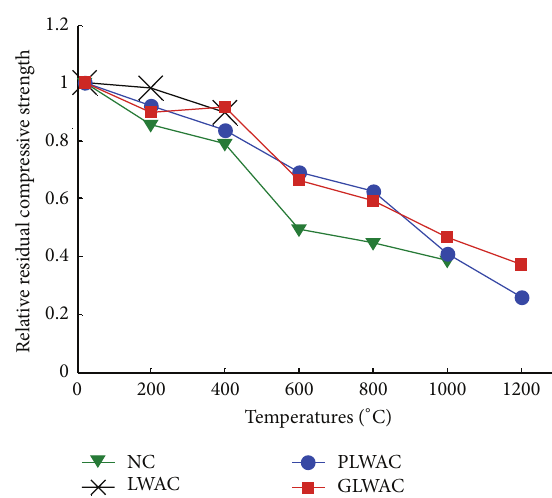
Figure 4: Relative residual compressive strength of the concrete specimens after exposure to elevated